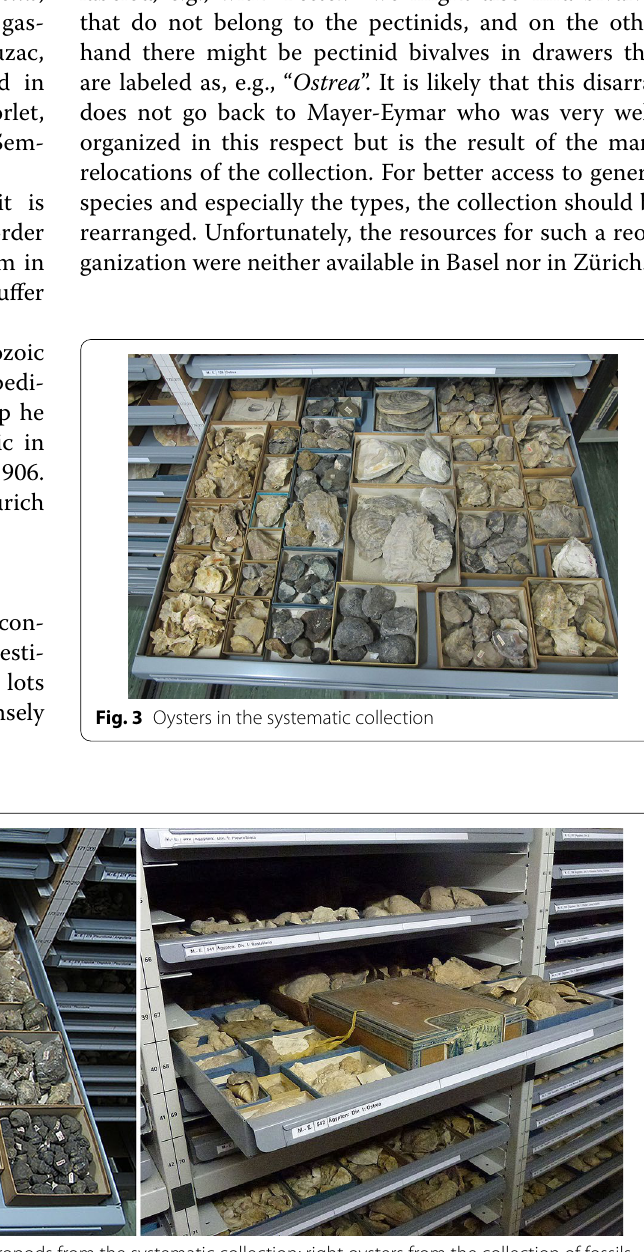
Fig. 2 Two examples of densely packed drawers; left various gastropods from the systematic collection; right oysters from the collection of fossils from